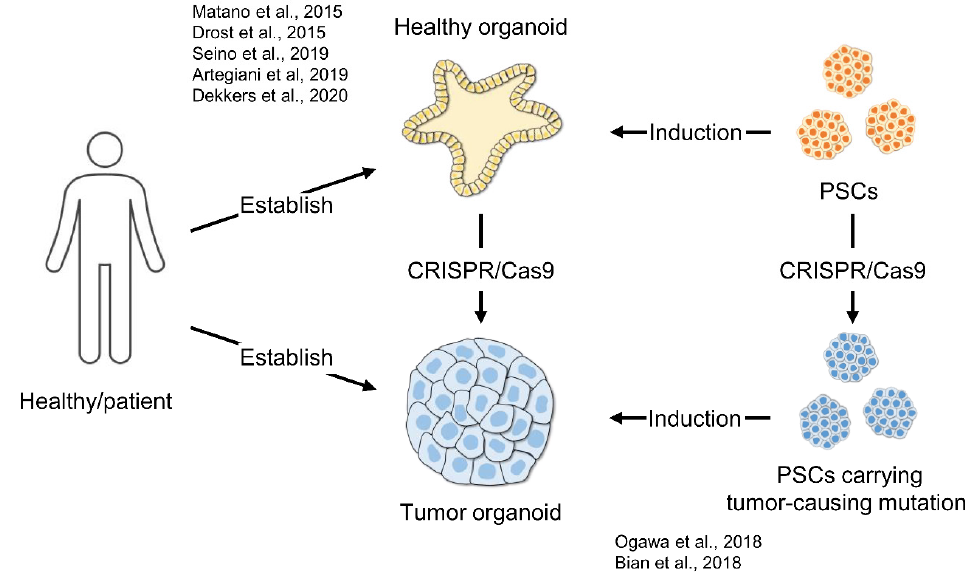
Figure 2. Tumor organoid model using CRISPR/Cas9 systems.